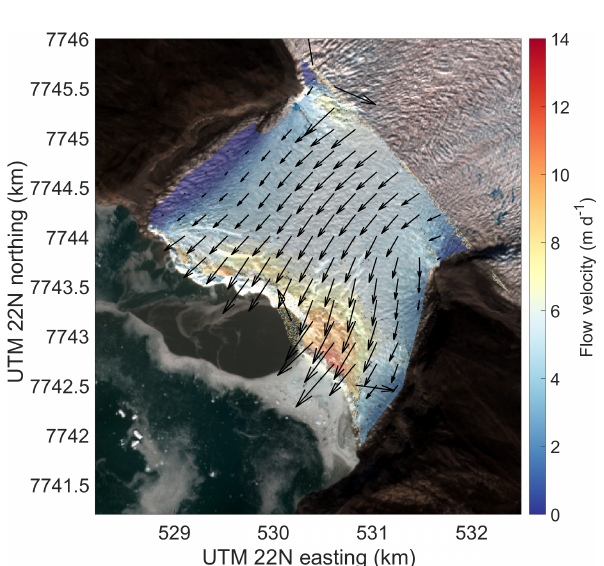
Figure 6. Flow velocity field derived from intensity tracking us- ing subsequent UAV acquisitions with a time difference of 4d (21 and 25 August 2016). Due to illumination differences between the acquisitions, shaded surface reliefs derived from structure from mo- tion were used for the image-matching procedure. Note the jumps in glacier flow speed close to the calving front that can be at- tributed to the presence of rifts. Erroneous values close to the calv- ing margin can be caused by image templates containing mixed in- formation from the glacier and the sea. Background: Sentinel-2A scene from 3 August 2016. This figure contains Copernicus Sen- tinel data